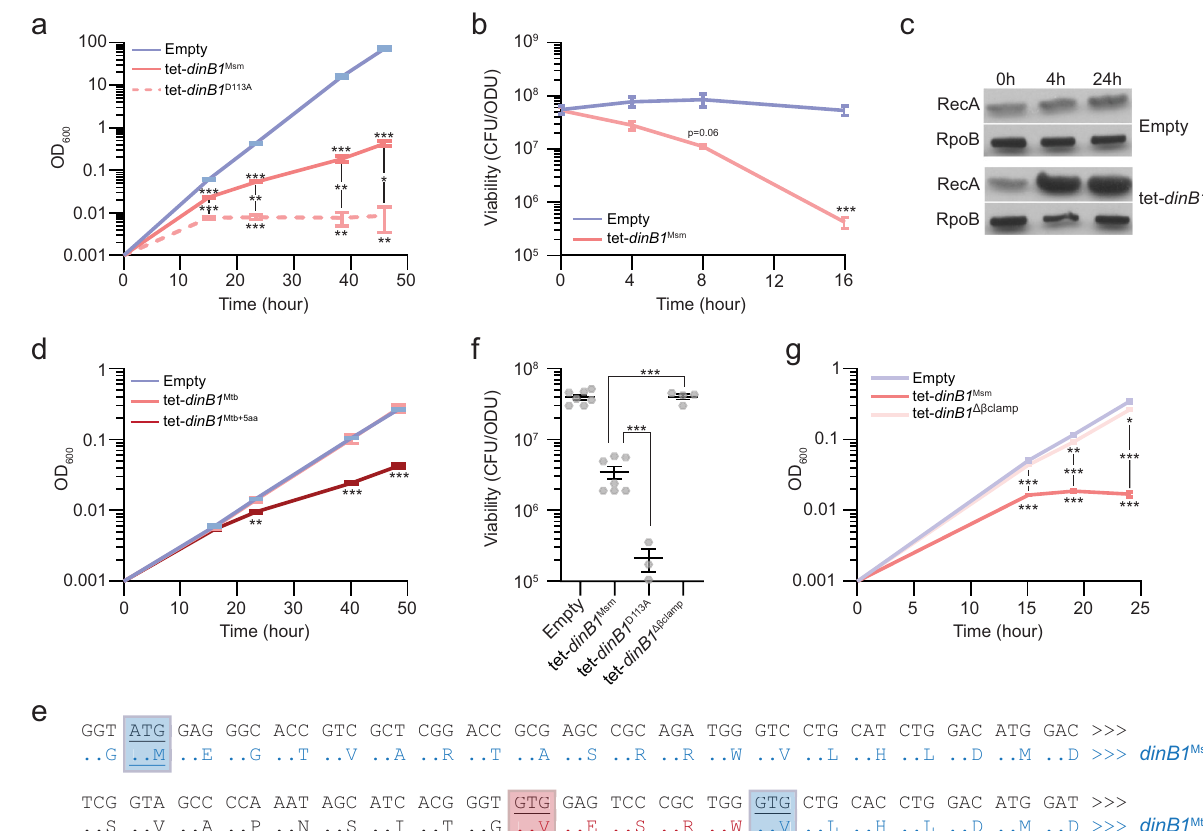
Fig. 1 | DinB1 Mtb activity requires fi ve N-terminal amino acids omitted from the annotated ORF. a , d , g Growth and b , f viability of strains carrying an inducible (tet=Anhydrotetracycline inducible promoter) DinB1 or its indicated derivatives (Msm= M.smegmatis ,Mtb=annotated M.tuberculosis DinB1,Mtb+5aa=Nterminal extended DinB1, dinB1 D113A=catalytically inactive M. smegmatis DinB1, Δβ clamp ( Δ QESLF:356 – 360aminoacidsof M.smegmatis DinB1))inpresenceofinducer.For a , the plotted OD value is the result of continuous dilution to maintain log phase growth (see methods). The viability in f was measured 24h after inducer addition. c Anti-RecA/RpoB immunoblot from indicated strains with indicated times of inducertreatment. e AlignmentofMsmandMtbDinB1N-terminiwiththepotential